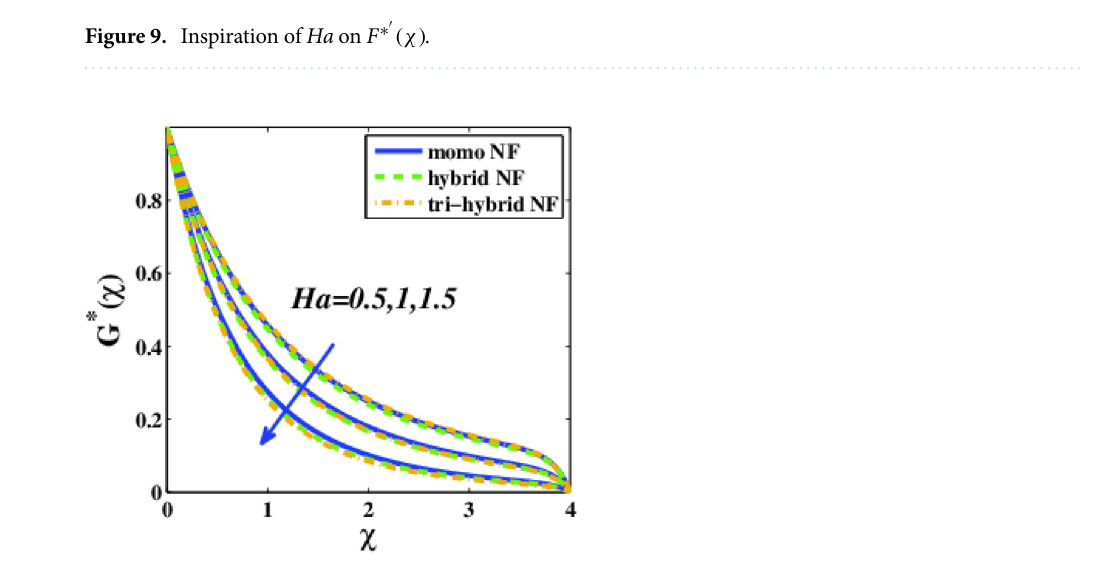
Figure 10. Impression of Ha on G ∗ (χ) .